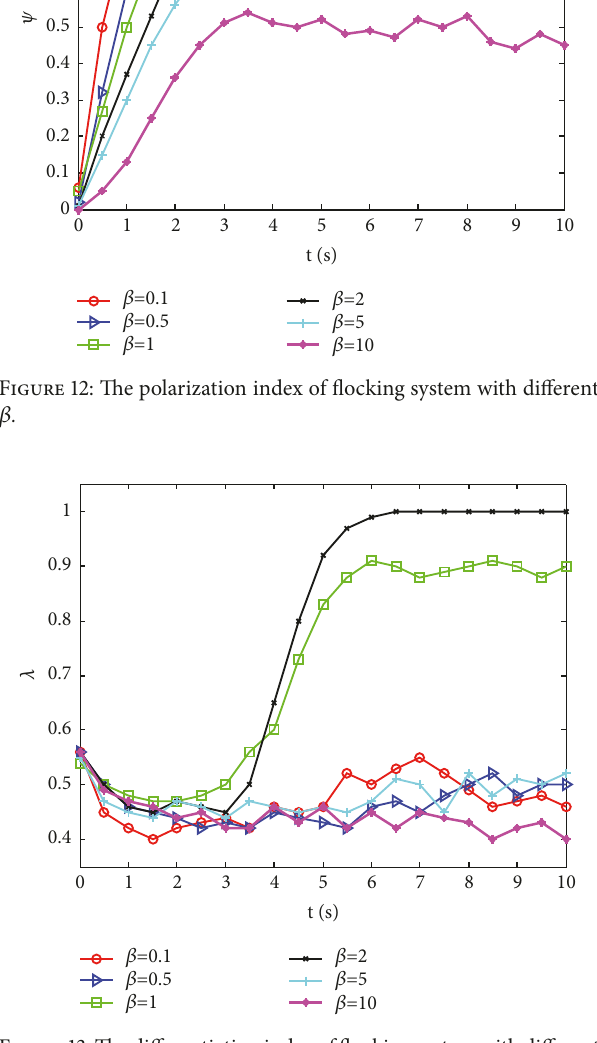
Figure13:Thedifferentiationindexofflockingsystemwithdifferent 𝛽